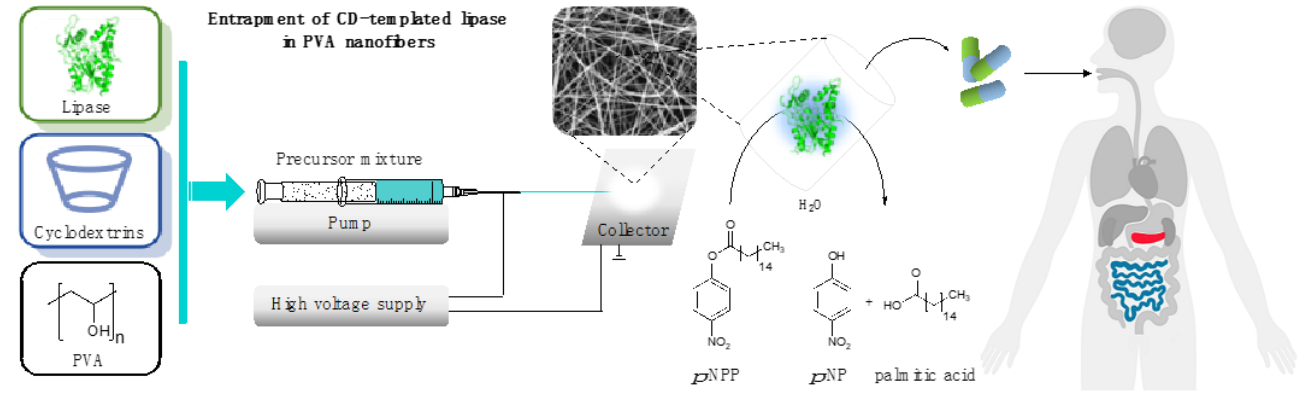
Figure 1. Formulation of cyclodextrin-templated lipase by entrapping in poly(vinyl alcohol) (PVA) nanofibers, applying electrospinning technique as a potential active pharmaceutical ingredients for pancreatin replacement therapy.